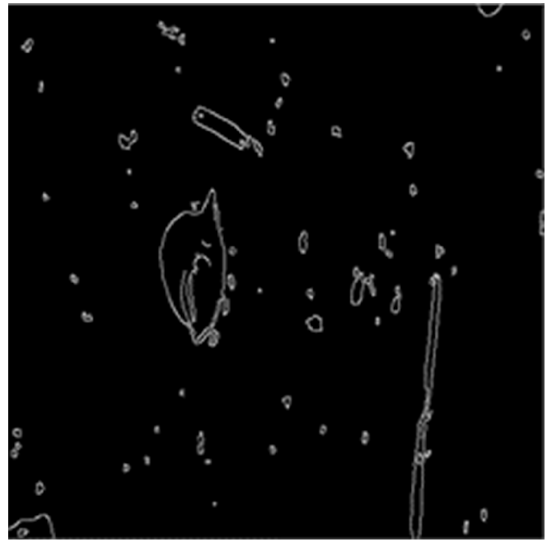
Figure 9. Improved Canny operator edge detection.